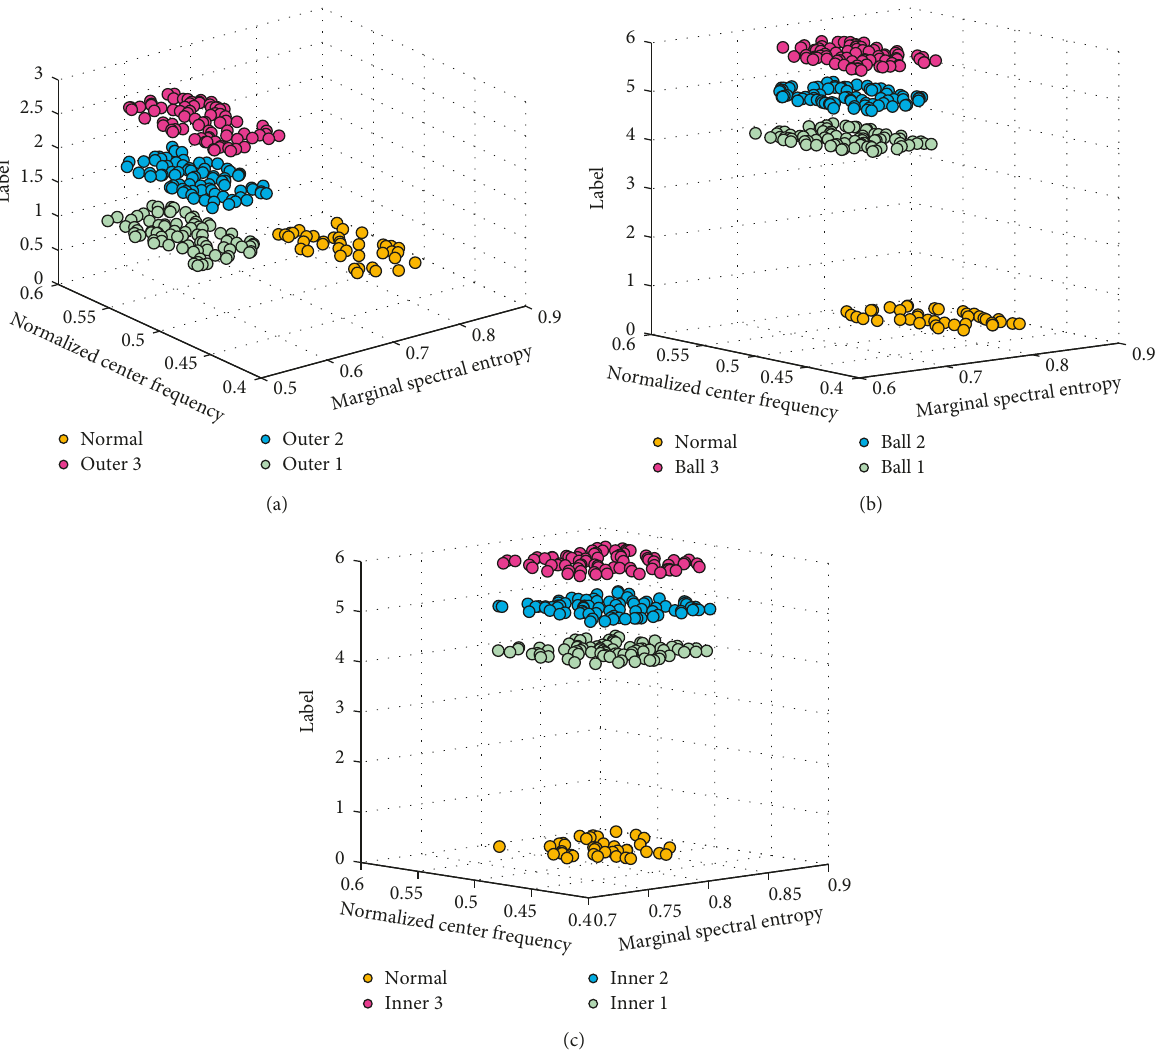
Figure 13: Intelligent diagnosis of different bearing faults under variable load. Diagnosis results of three different damage degrees of the bearing outer race under 0hp load (a), bearing rolling balls under 1hp load (b), and bearing inner race under 2hp load